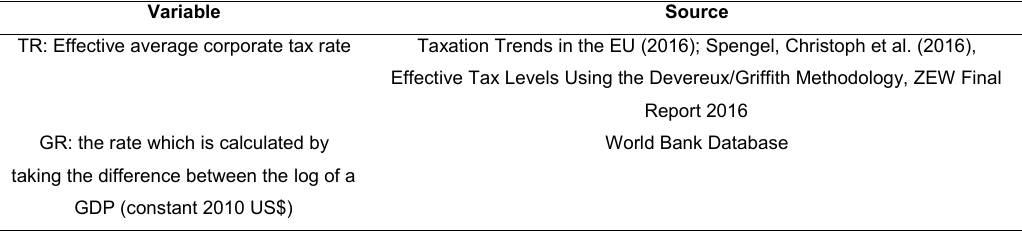
Table 1. Variables and